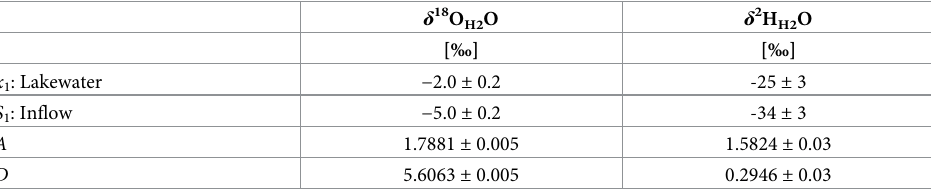
Table 7. Summary of input values for the FRAME model: Lakewater sample, inflowing water (single-source) and auxiliary parameters calculated from the meteorological conditions according to Craig-Gordon